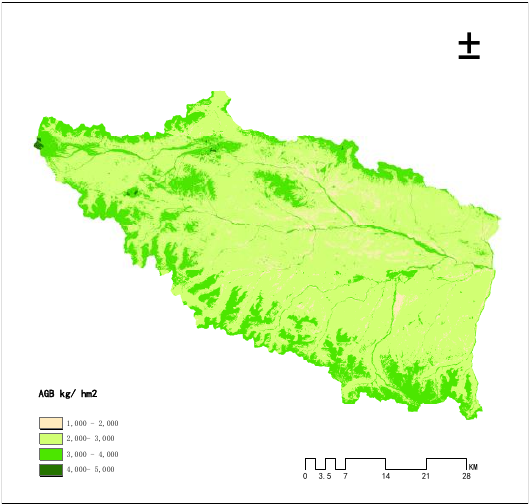
Figure 7. Trends in AGB in the Muli region from 2000 to 2021.